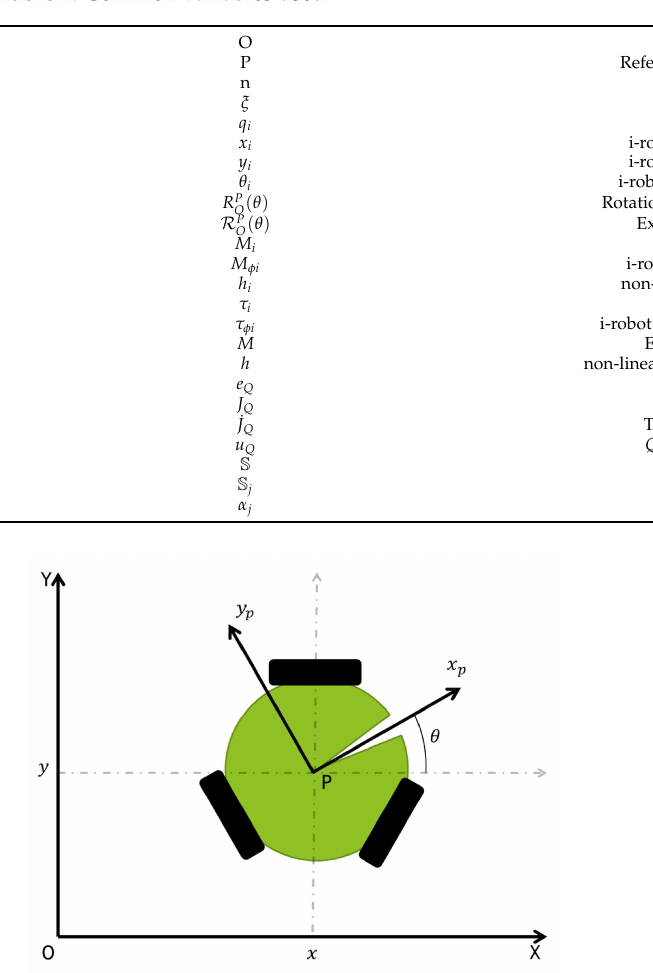
Table 1. Common variables used.